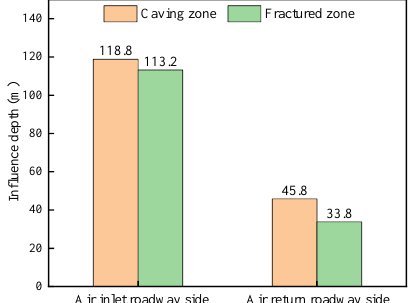
9 of 15 Figure 7. Comparison diagram of gas mass fraction variation curve in caving zone and fracture zone.